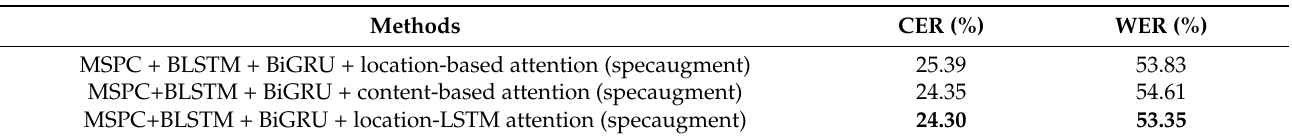
Table 6. Results of the ablation study of the proposed MSPC architecture. Our experimental results are highlighted in bold.